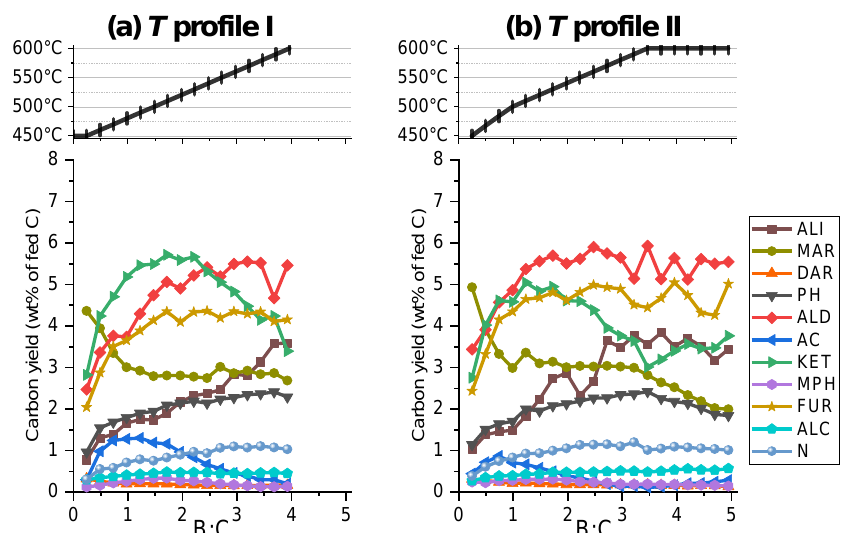
Figure 5. Carbon recovery of vapor products quantified by GC-FID when upgrading wheat straw pyrolysis vapors over P / HZSM-5 / γ -Al 2 O 3 following ( a ) a constant temperature increase of 10 ◦ C per biomass injection and ( b ) an adapted temperature increase, as indicated above the graphs. The momentary carbon yields per biomass injection are shown. Legend applies to both graphs.